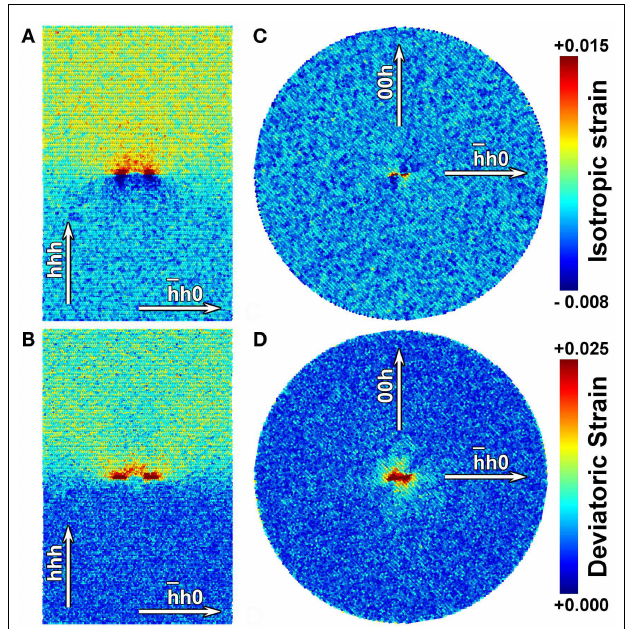
FIGURE 2 | Isotropic (A,C) and deviatoric (B,D) strain fields in the systems of Figure 1 . Cross-sections refer to Pd nanocrystals with edge (left column) and screw (right column) dislocation lines,